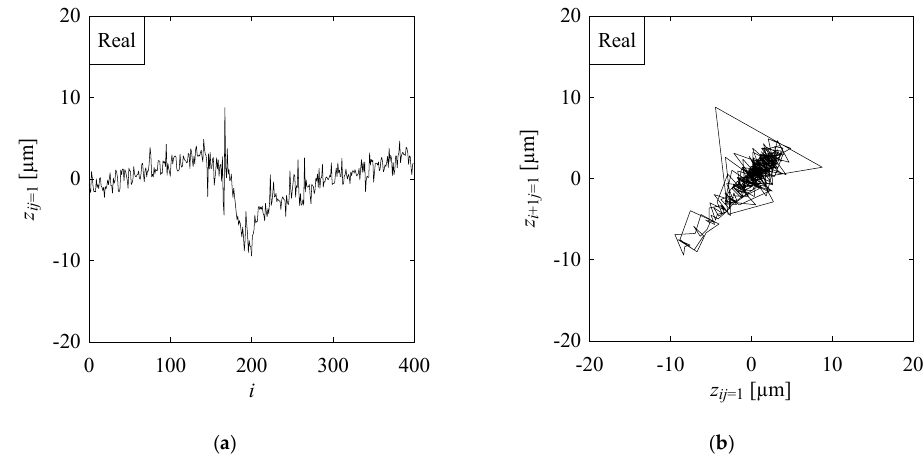
Figure 4. Outcomes of IC: ( a ) real surface heights; ( b ) return map of ( a ).